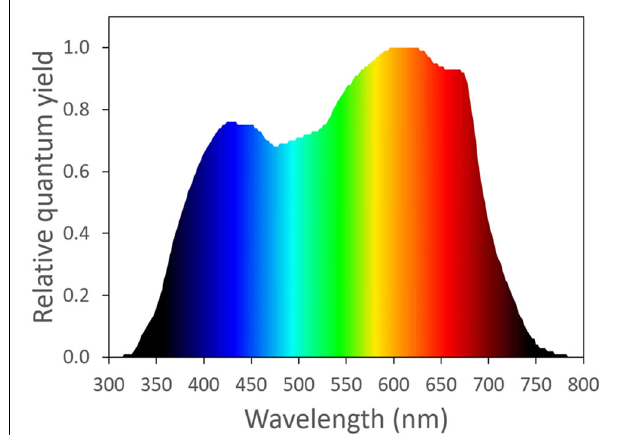
FIGURE 1 | The normalized action spectrum of the maximum quantum yield of CO 2 assimilation for narrow wavebands of light from ultra-violet to far-red wavelengths (McCree, 1971). Redrawn using data from Sager et al.